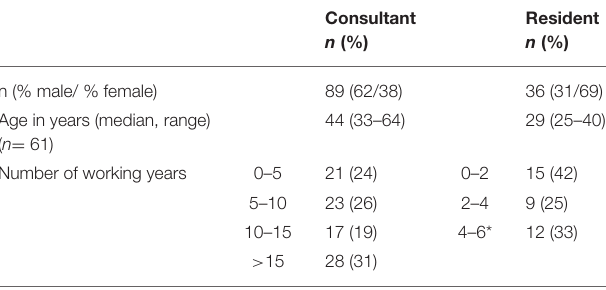
TABLE 1 | Demographics of consultants in neurology and